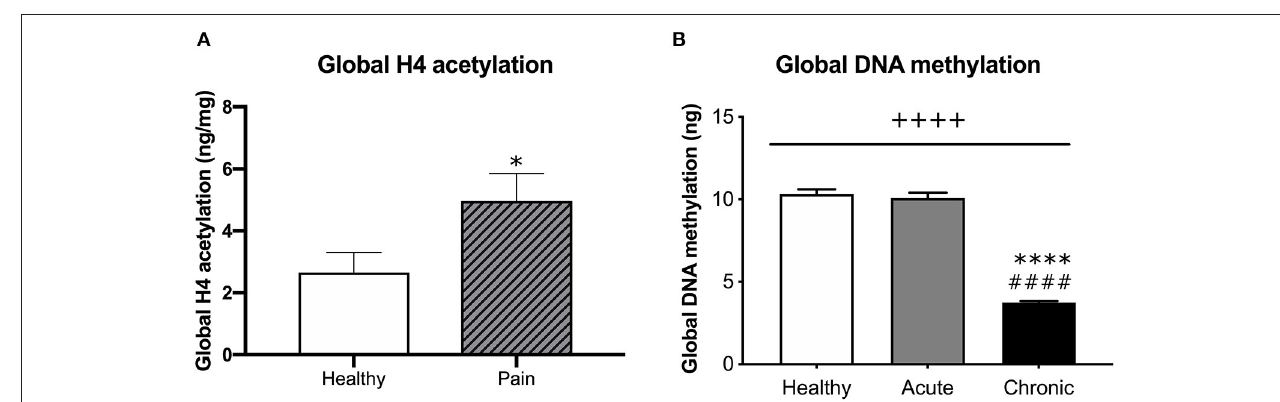
FIGURE 3 | (A) Comparison of global H4 acetylation between healthy participants and participants that presented with pain (aLBP and cLBP). Data presented as H4 acetylation (ng/mg of total protein) + SEM. * p < 0.05 vs. healthy controls. (B) Global DNA methylation was quantified from healthy controls, aLBP, and cLBP participants. Data presented as mean ng methylation per 150 ng total DNA + SEM. + + ++ p < 0.000 group effect; **** p < 0.0000 vs. healthy controls, #### p < 0.0000 vs. aLBP.